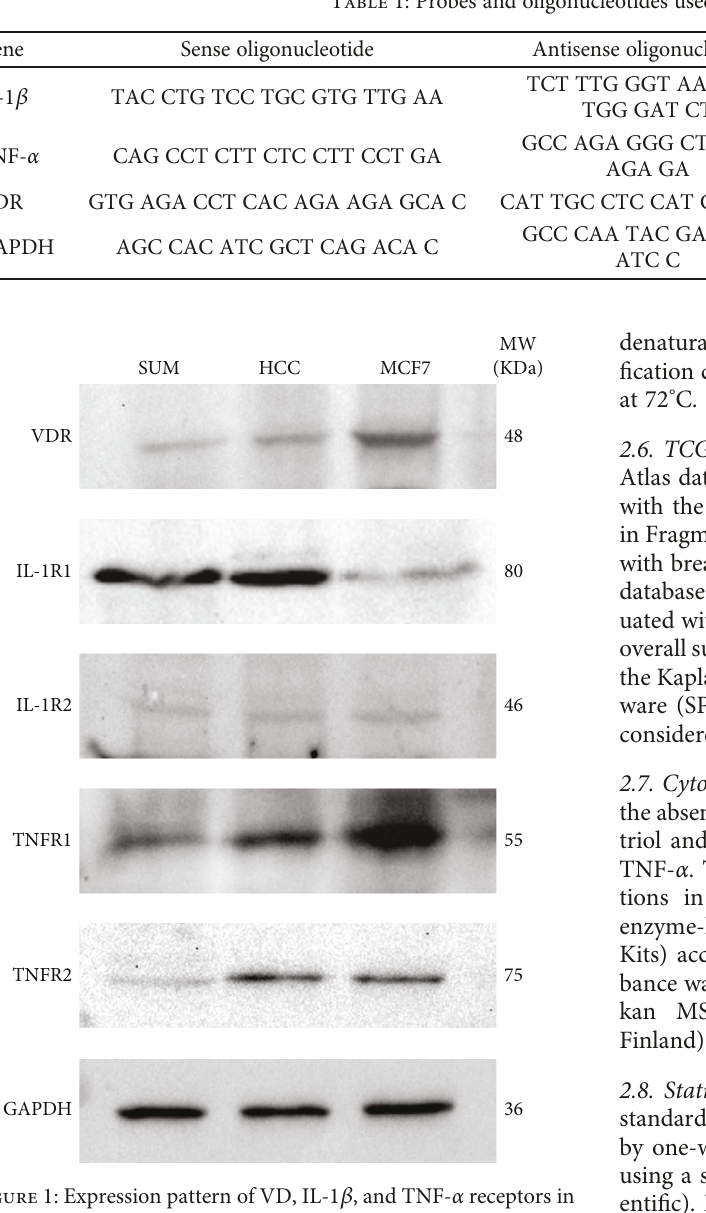
Table 1: Probes and oligonucleotides used in qPCR assays.